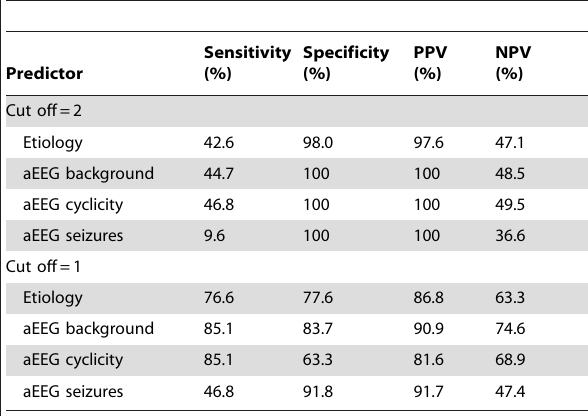
Table 5. The predictive value of aEEG features and etiology for abnormal prognosis in neonates with